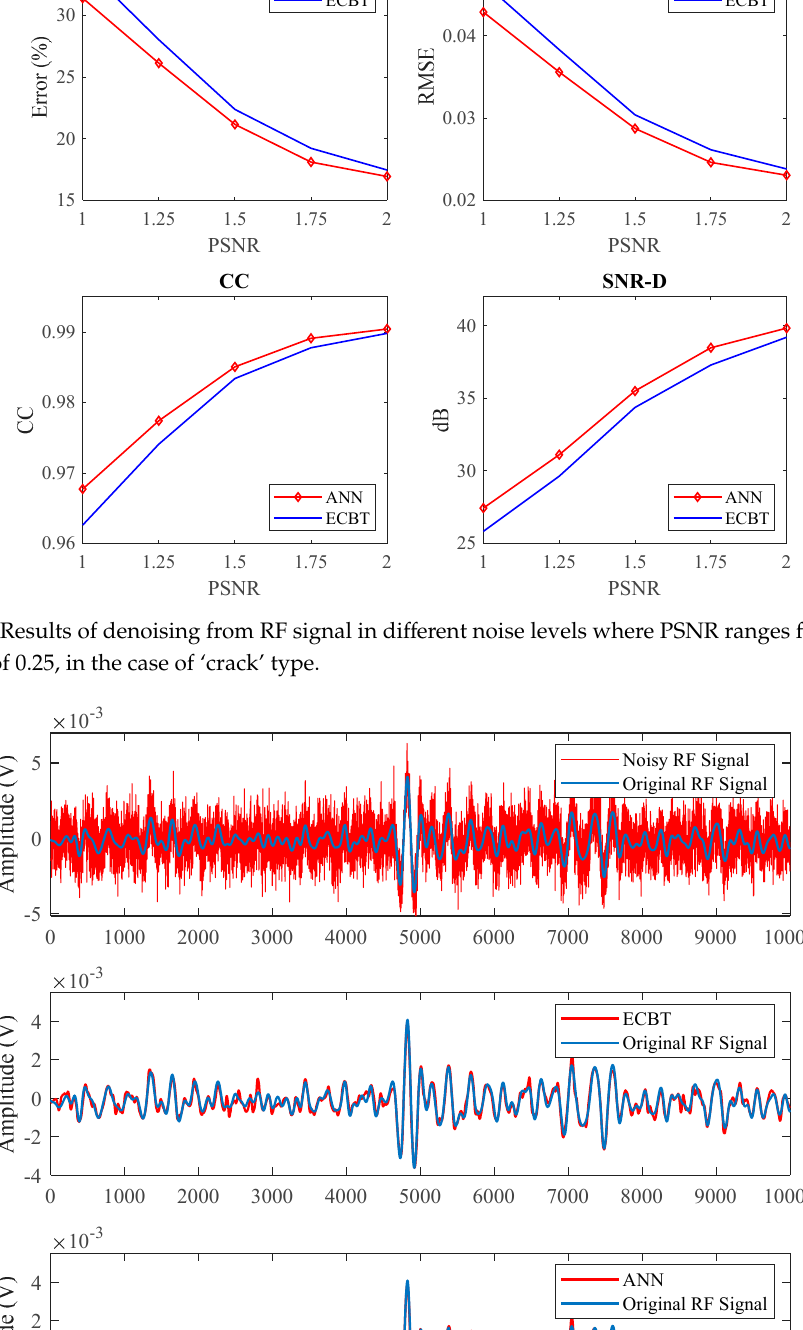
Figure 8. Denoising of RF signal, ‘crack’ type, in the case of PSNR = 1.